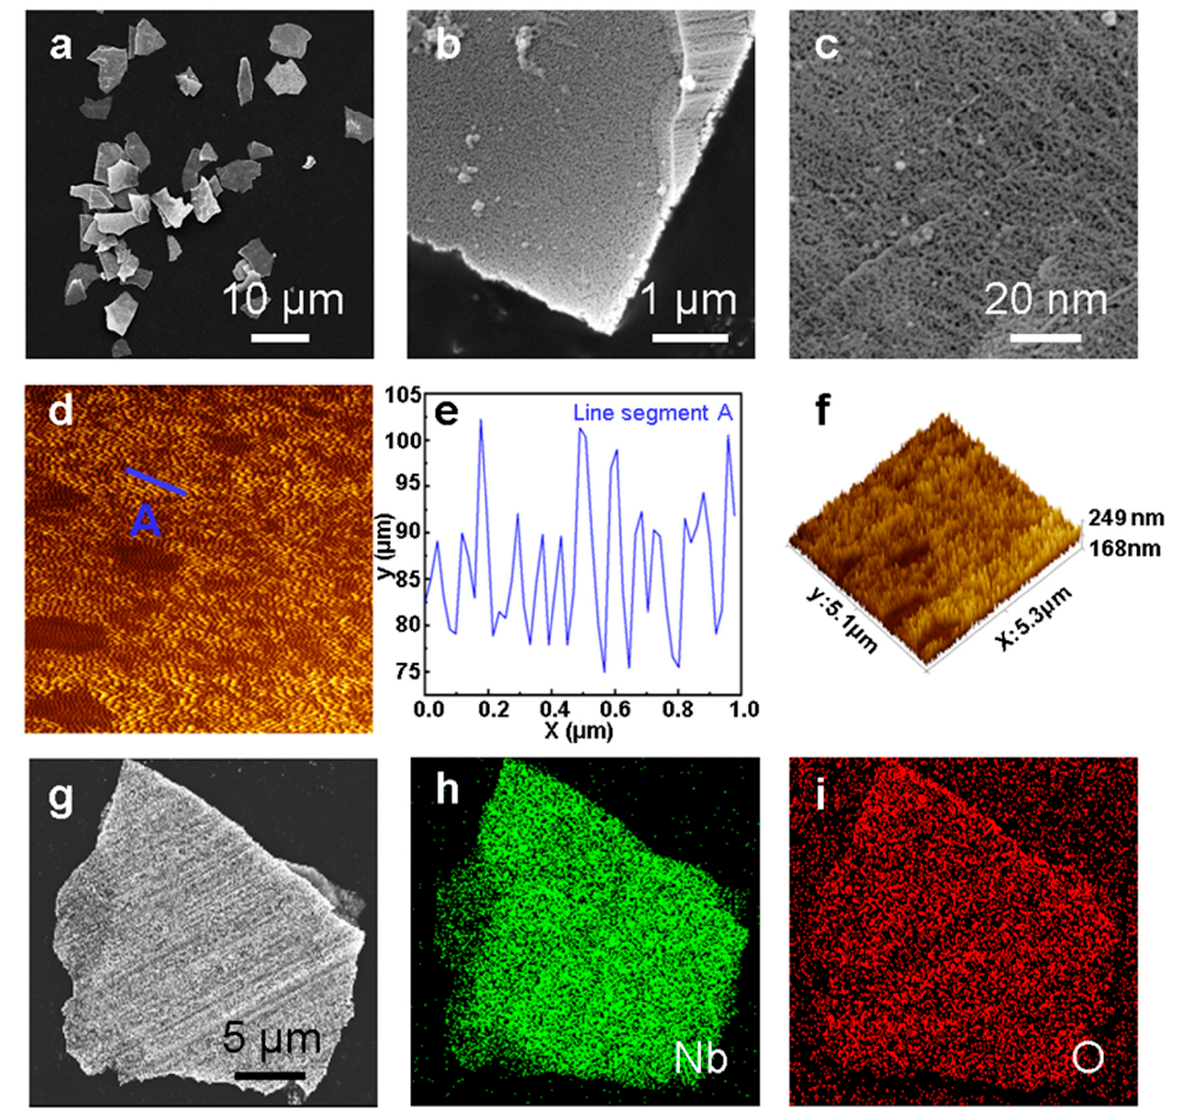
Figure 1. ( a – c ) SEM images of the porous niobium oxide obtained by anodic oxidation and ( d – f ) AFM images of the porous niobium oxide obtained by anodic oxidation. ( g – i ) SEM images and elemental mapping images of P-Nb 2 O 5 . The Nb and O are represented in green and red, respectively. The greater surface area of the P-Nb 2 O 5 indicated that there was increased contact area with the active substances. The high-resolution transmission electron microscopy (HRTEM) image showed the P-Nb 2 O 5 microstructure and a state of void distribution (Figure 2a–c). Moreover, an abundance of mesopores was observed in the oxidized structure of the P- Nb 2 O 5 , which resulted in an increase in the active interfacial energy and the strength of the physical adsorption on the sulfur (Figure 2b). A deeper probe into the amorphous structure was carried out by HRTEM observation. As shown in Figure 2d–f, the energy dispersive spectroscopy (EDS) mapping further demonstrated that that Nb and O were evenly distributed in the oxide (Figure 2e,f), which also indicated the successful synthesis of P-Nb 2 O 5